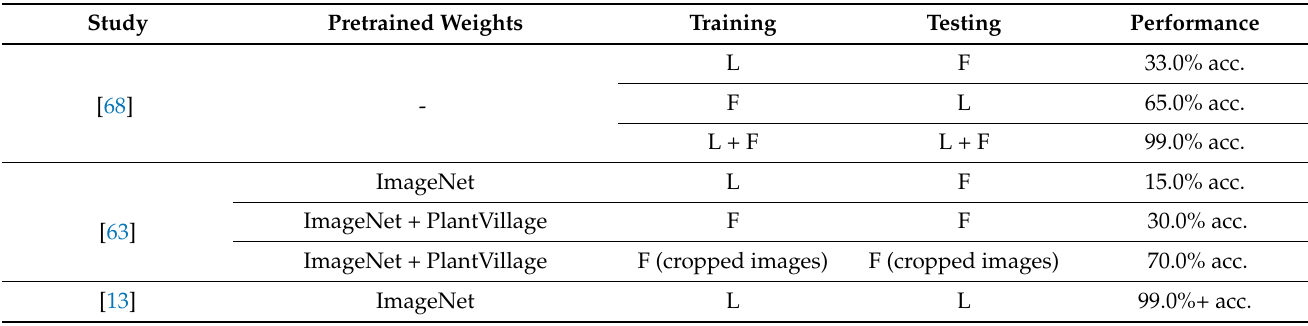
Table 1. Performance comparison of field vs. laboratory